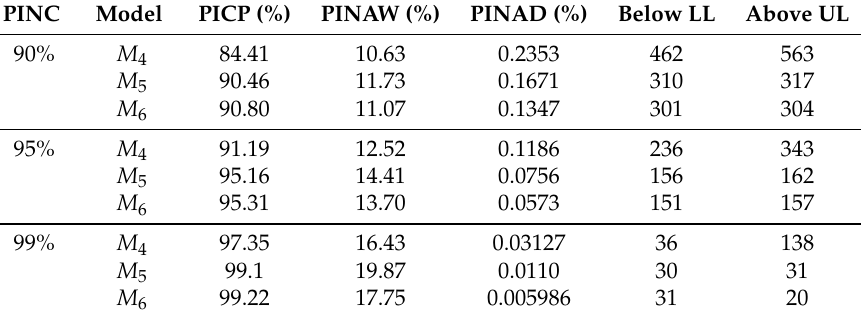
Table 5. Comparative evaluation of models using prediction interval (PI) indices. Below LL = number of forecasts below the lower prediction limit, Above UL = number of forecasts above the upper prediction limit.